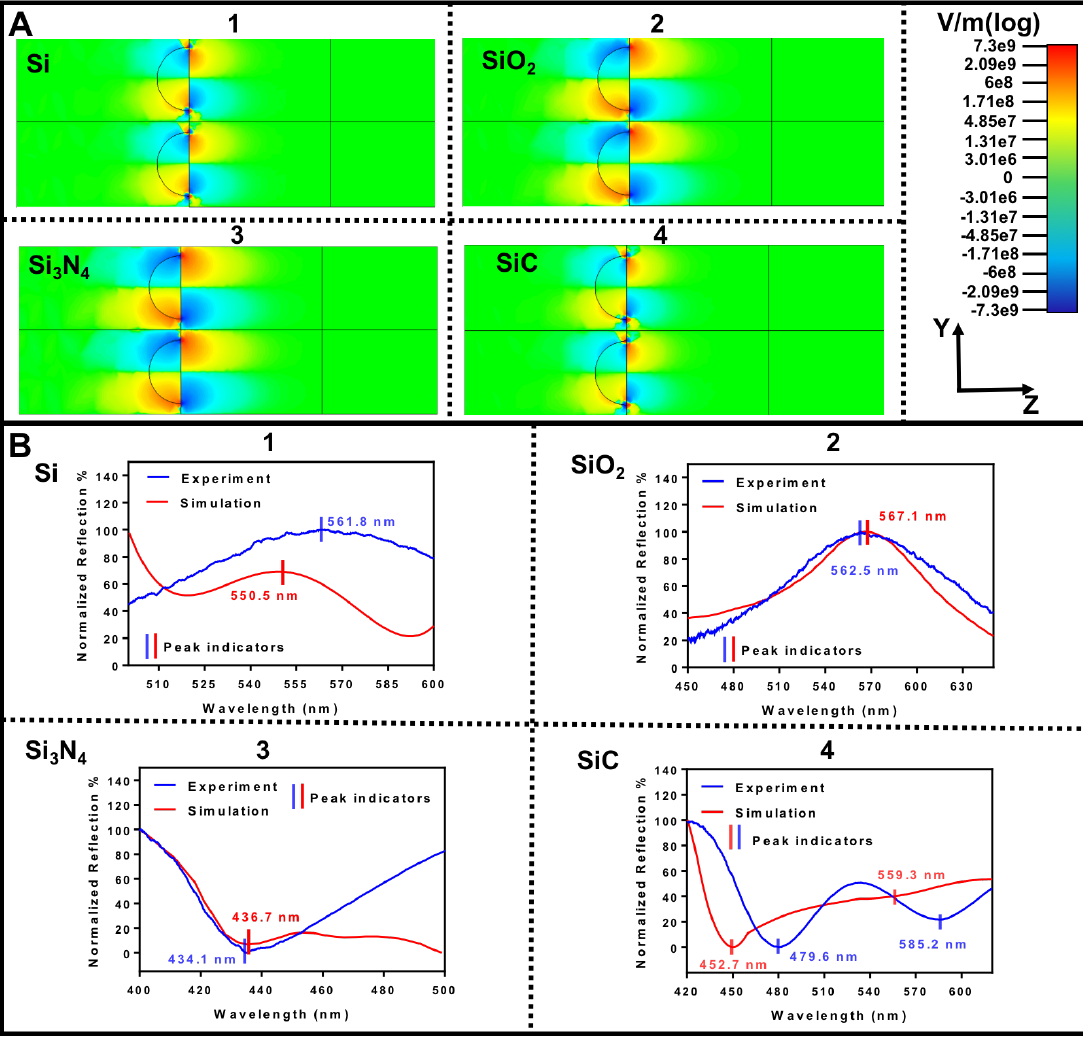
Figure 4. Finite element simulations: ( A ) shows the electric field of plasmons on AuNI and its penetration inside the supporting substrates (1) Si, (2) SiO 2 , (3) Si 3 N 4 and (4) SiC; ( B ) exhibits the wavelength of the electron oscillations compared with the experimental measurements for LSPR in (1) Si, (2) SiO 2 , (3) Si 3 N 4 and (4)